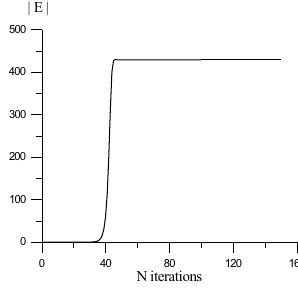
Figure 2. Numerical solution depending on iterations